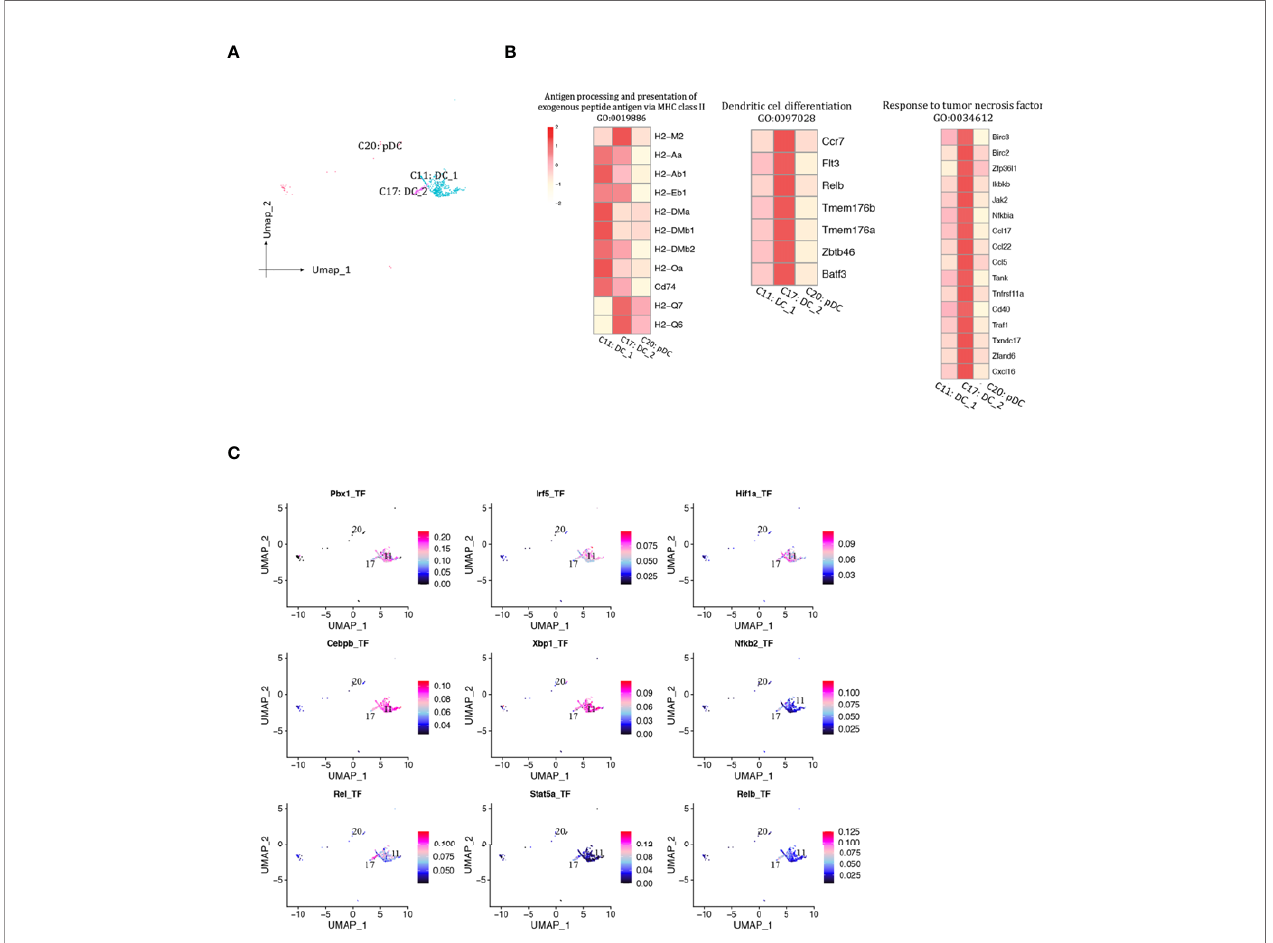
FIGURE 11 | DCs presented in the allografted kidneys. (A) Integrated UMAP projection of three DC cell clusters (11, 17, 20) identi fi ed in the kidney grafts, colored according to cluster designation. Cell identities are annotated above the cell dots. (B) Heatmap showing scaled expression of genes enriched in GO pathways. Scale bar is shown on the left top. (C) Feature plot showing the AUC scores for the expression of gene sets regulated by transcription factors, as estimated with SCENIC, in clusters 11 and 17. AUC score bar is shown on the right. DC, dendritic cell; pDC, plasmacytoid dendritic cell; UMAP, Uniform Manifold Approximation and Projection; GO, gene ontology; AUC, area under the curve; SCENIC, single-cell regulatory network inference and